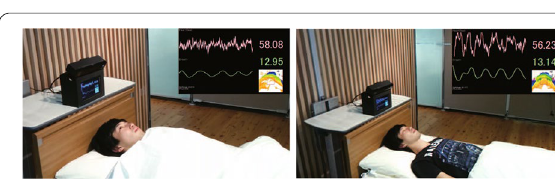
Fig. 7 Vital data measured by RGB-D camera